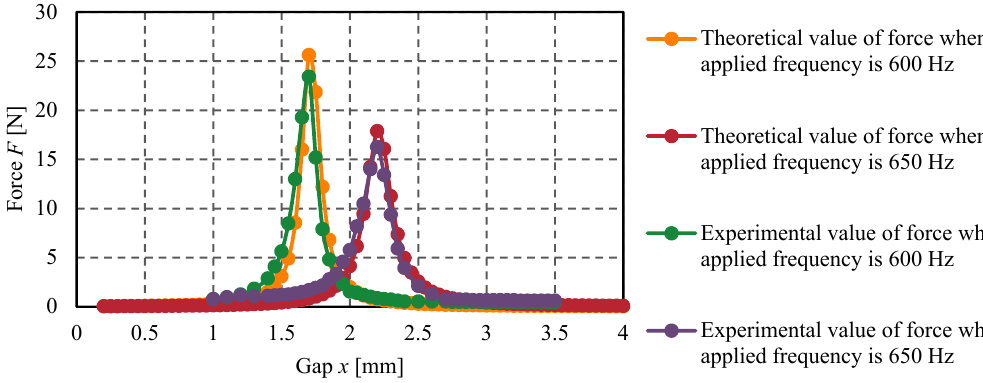
Figure 14. The comparison of the characteristics curve of electromagnetic attractive force when the applied frequency f is 600 Hz and 650 Hz.